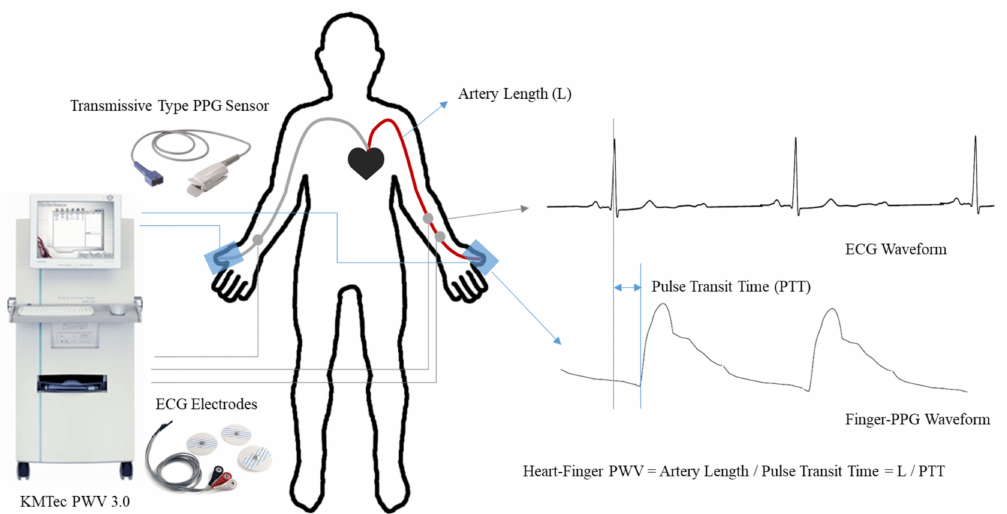
Figure 2. Measurements of heart–finger PWV. The time di ff erence between the characteristic points